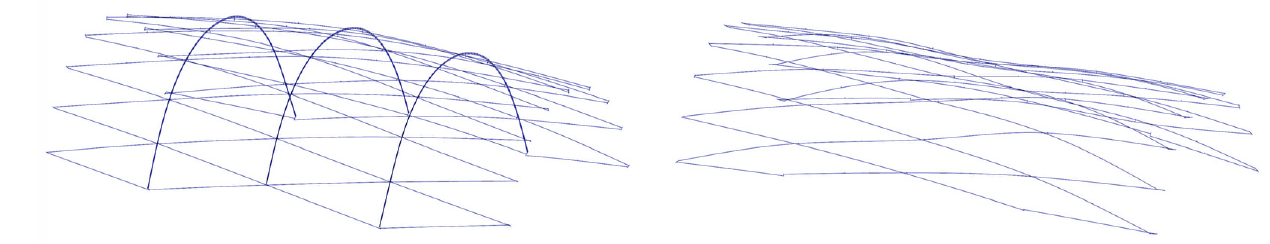
Figure 16. TEL-Gridshell geometry after relaxation, with bracing system ( left ) and without bracing system ( right ). Amplification factor = 5.